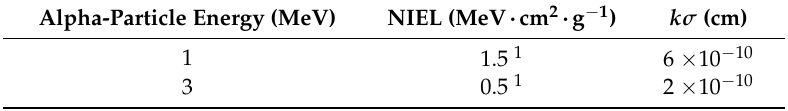
Table 3. Values of non-ionizing energy loss (NIEL) and k σ for 1 MeV and 3 MeV alpha particles in the GaAs